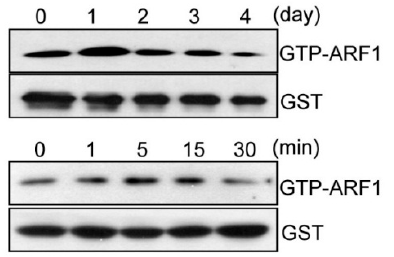
Figure 1. Changes in activity of ADP-ribosylation factor 1 (ARF1) during osteoclast differentiation. ARF1 activity was measured by pull-down assays and immunoblot analysis. Level of guanosine triphosphate (GTP)-bound ARF1 was determined after osteoclast differentiation ( upper panel) and after transient stimulation by RANKL ( lower panel). Glutathione S-transferase (GST) was used as a loading control.